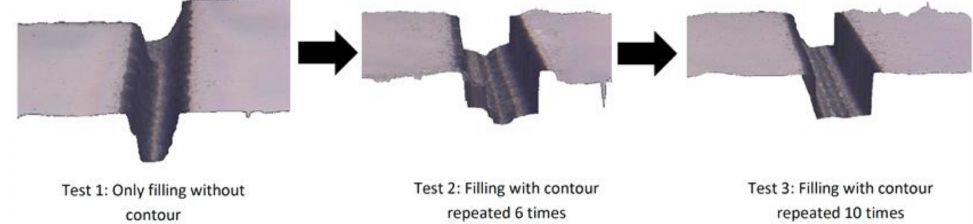
Figure 3. Example illustrating the effect of the laser contouring process ( left ) microchannel without contouring, ( middle ) microchannel with contouring depth less than channel engraving depth ( right) contouring with adequate number of repetitions (depth).